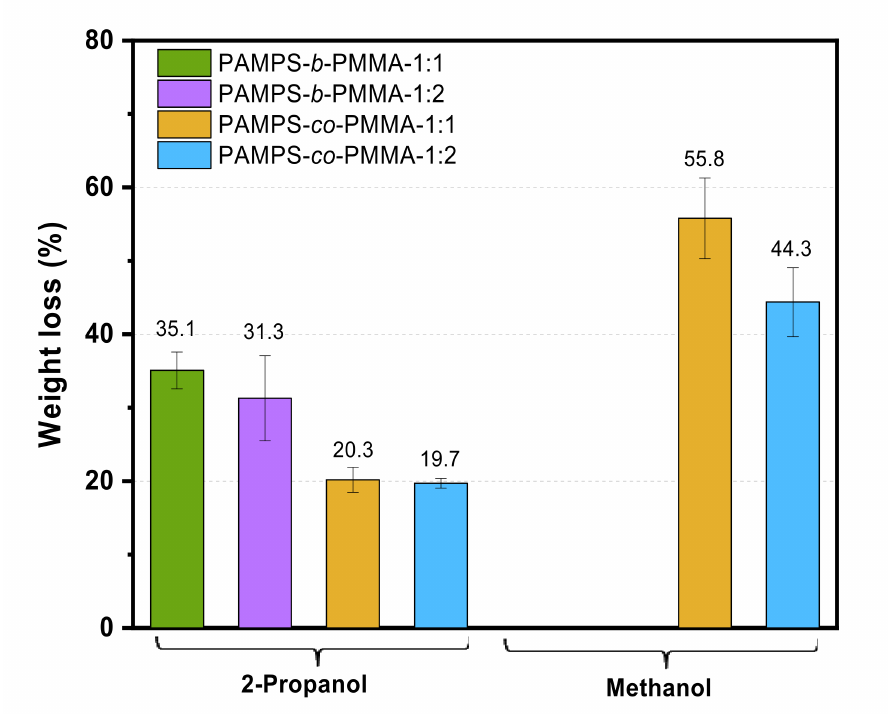
Figure 5. Weight loss percentages for membranes PAMPS- b -PMMA and PAMPS- co -PMMA in 2- propanol and